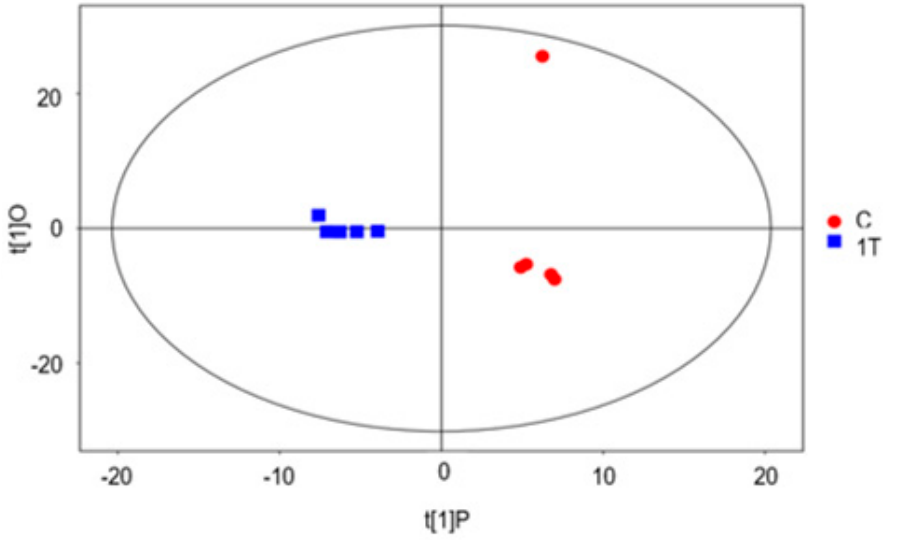
Figure 6. Dispersion points diagram of the OPLS − DA model of group 1T versus Group C.